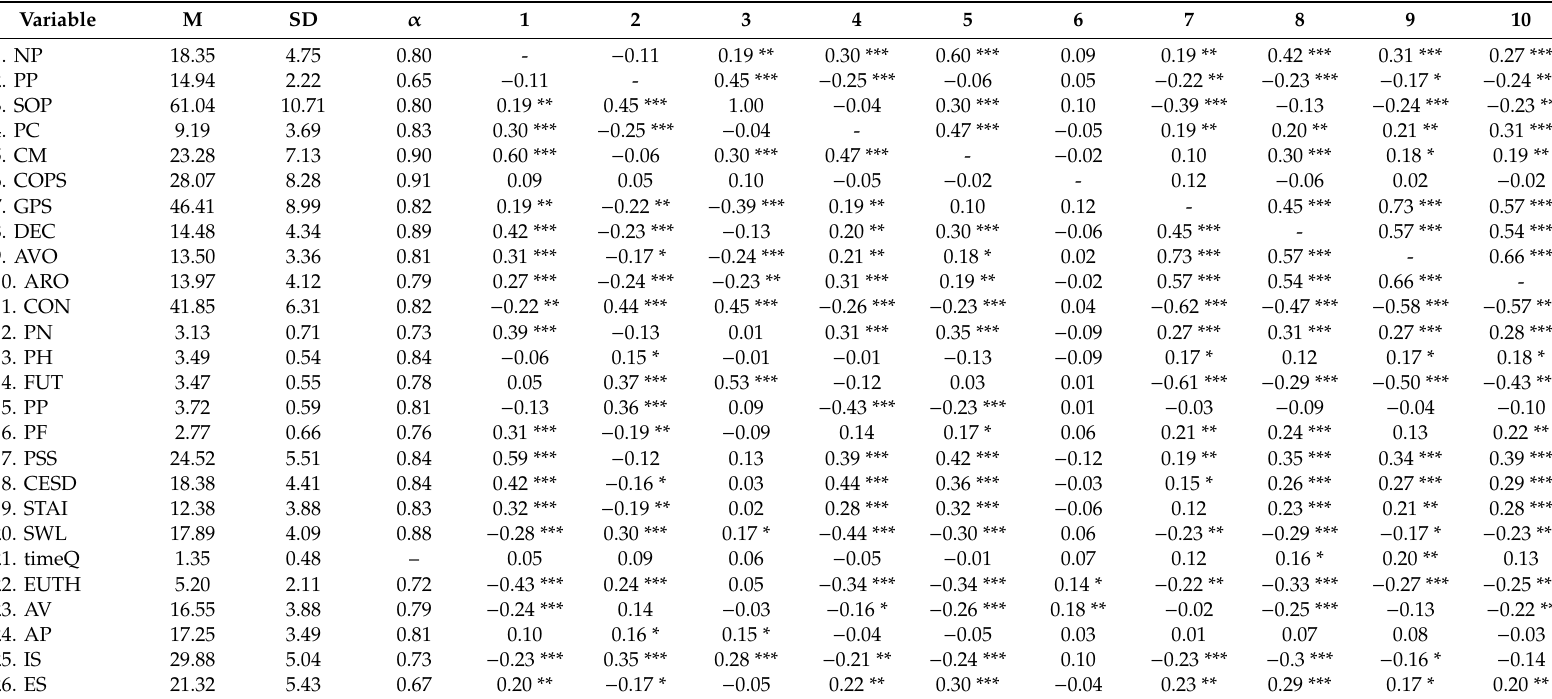
Table 1. Means, standard deviation, Cronbach’s alpha, and